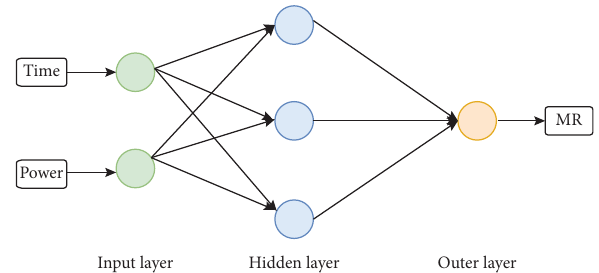
Figure 1: Confguration of artifcial neural network